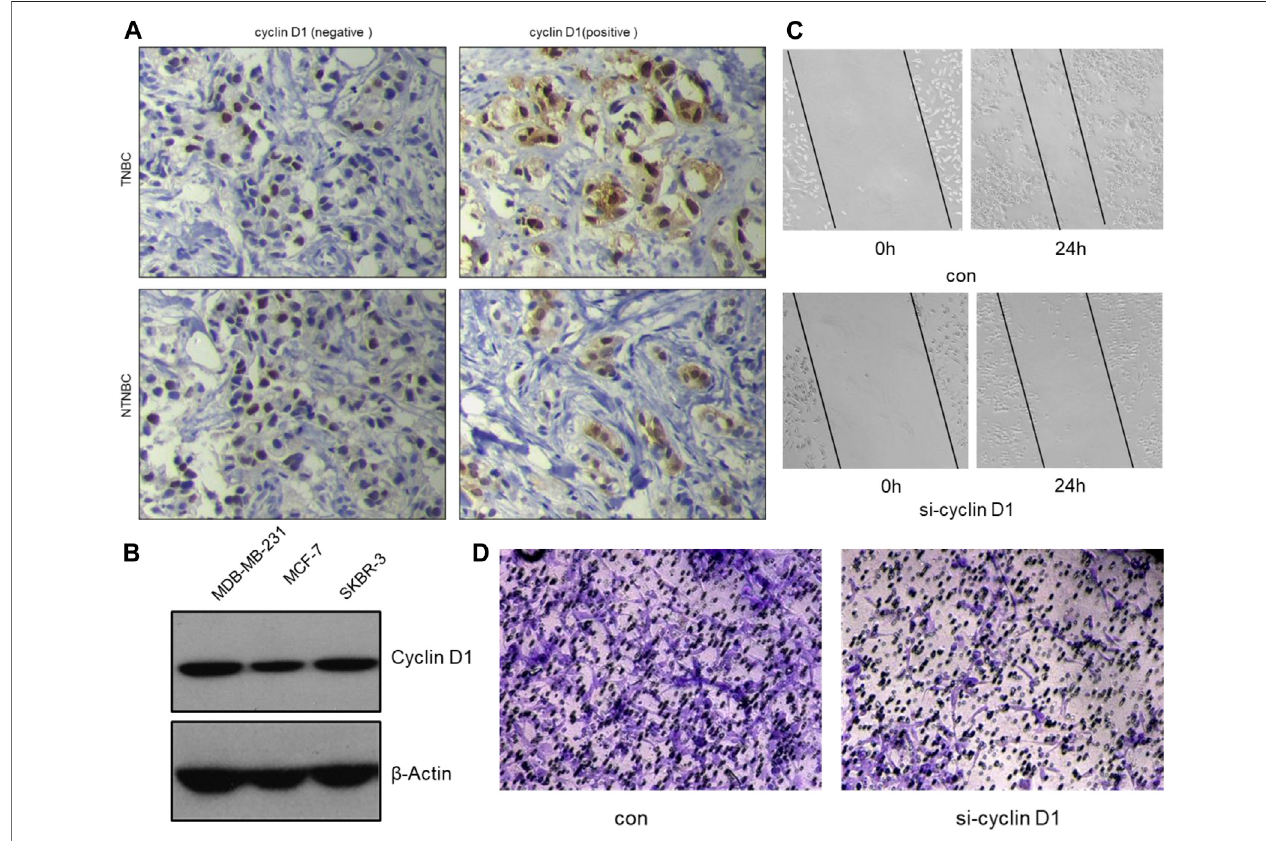
FIGURE 7 | The inhibitory effect of α -mangostin on breast cancer cell migration and invasion is also dependent on the tRXR/Akt/cyclin D1 pathway. (A) Representative images for the different expression of cyclin D1 by immunohistochemistry in tissues samples from TNBC and NTNBC patients. (B) The different expression of cyclin D1 by western blotting in different breast cancer cell lines. (C,D) The inhibitory effect of MG-a on MDA-MB-231 cells migration/invasion.